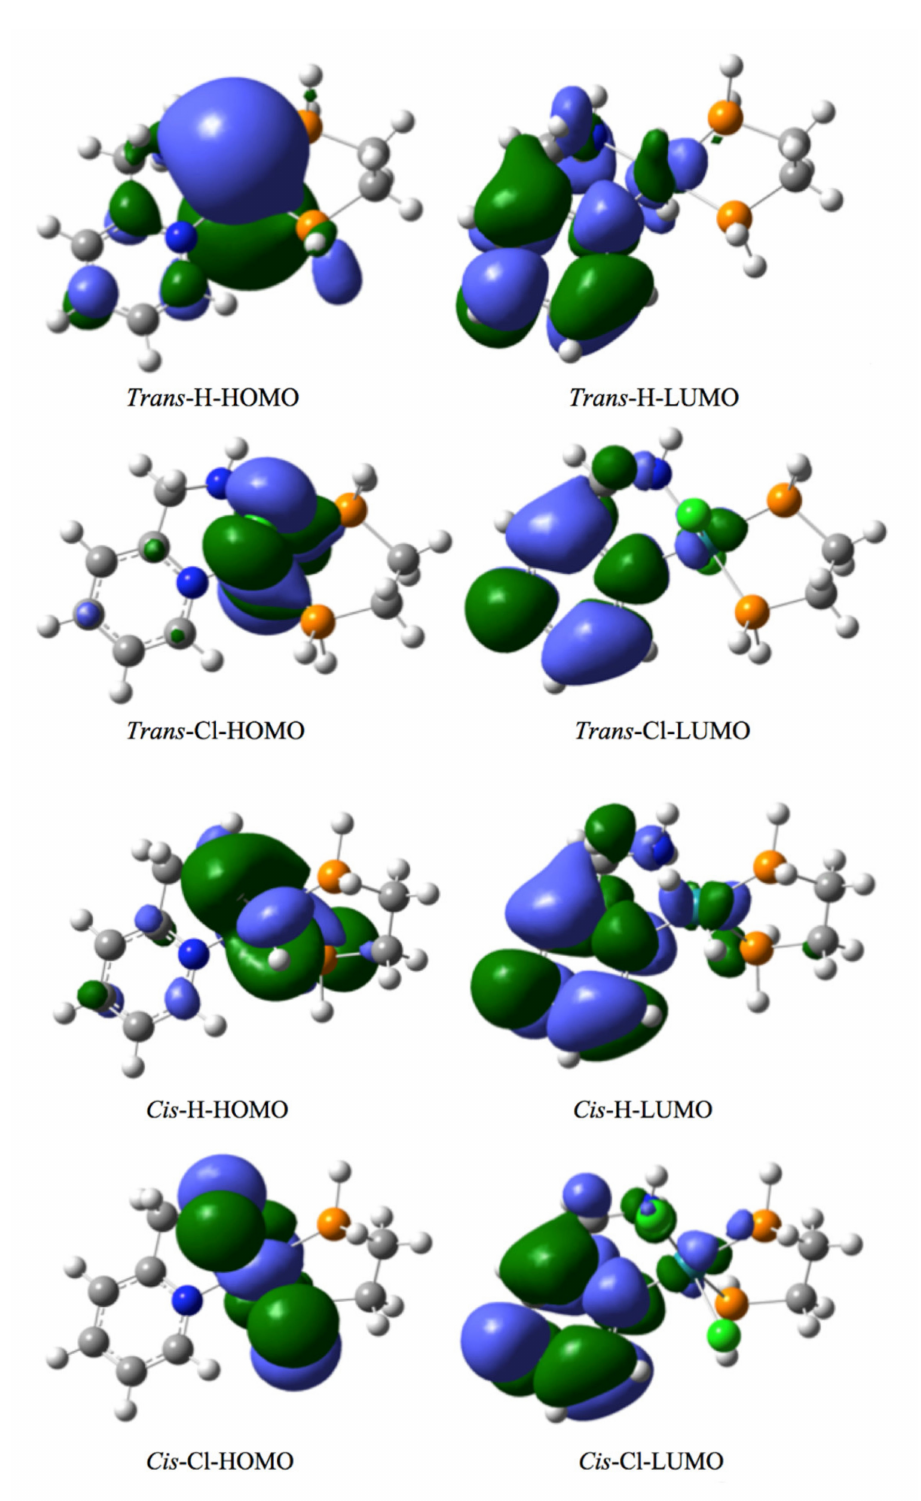
Figure 7. HOMO and LUMO molecular orbitals for the bidentate ligand Ru(II) complexes at different